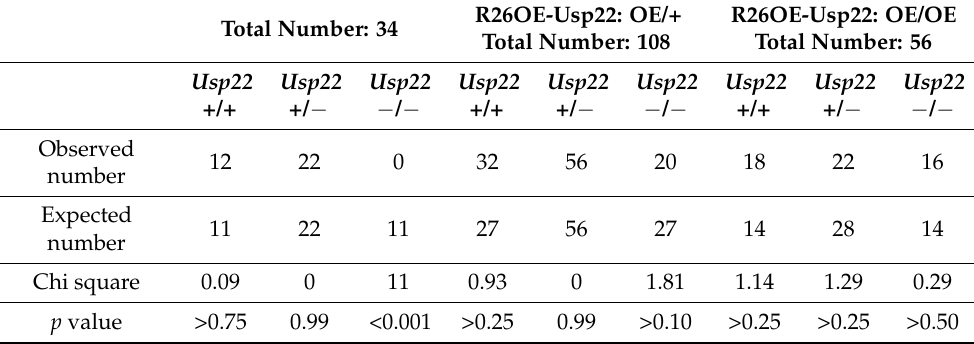
Table 2. Mendelian ratios of the respective number of adult mice collected from OE/+ or OE/OE Usp22 line crossed with Usp22 +/ − heterozygotes for the Usp22 null allele described in Koutelou et al.,